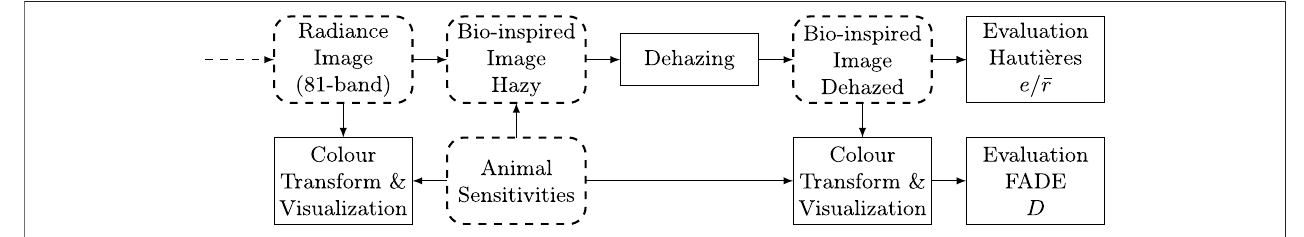
FIGURE3| Designofthesecondstepofprocessing.Fromtheradianceimage,wesimulatethesensingprocess,applydehazingandevaluatetheresultaccording to image data. An alternative color visualization pipeline permits looking at colour images and provide an alternative evaluation of the result. The dotted arrow corresponds to the connection from Figure 1